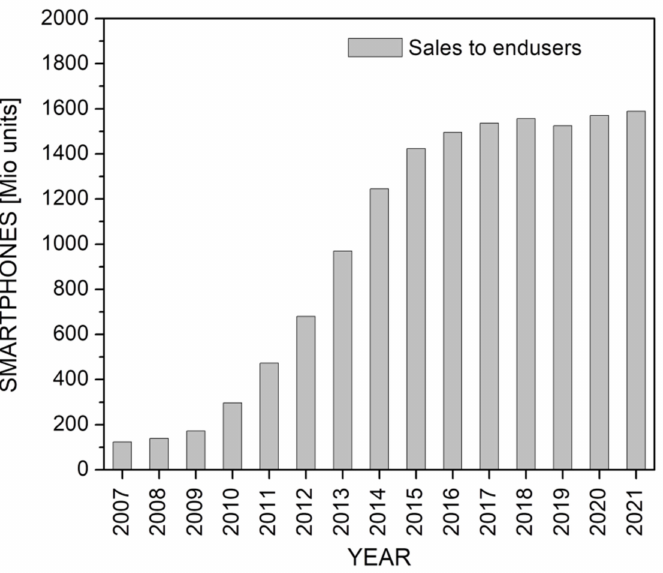
Figure A5. Global sales of smartphones to end-users from 2007 to 2021